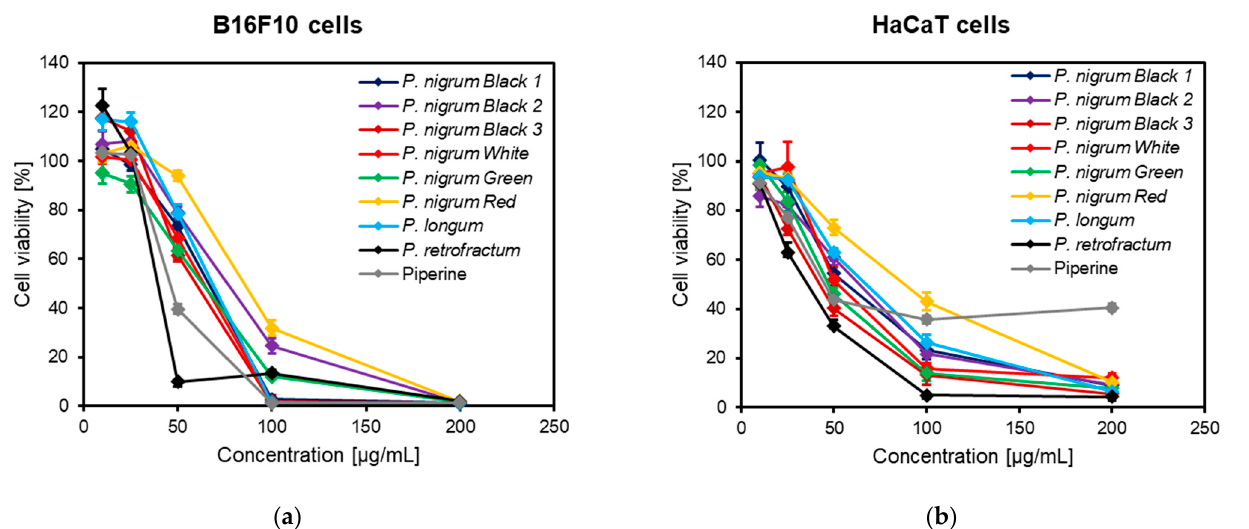
Figure 3. Concentration–response curves (10–200 μ g/mL) showing the effect of the methanolic fruit extracts obtained from different spices of genus Piper and piperine in ( a ) B16F10 and ( b ) HaCaT cells. Cells were seeded in 96-well plates (3 × 10 3 /well) and incubated for 72 h (B16F10 cells) or 48 h (HaCaT cells) with different concentrations of Piper extracts (10–200 μ g/mL) or piperine (10–200 μ g/mL). Data are presented as percentage cell viability (%) in comparison to the solvent (DMSO)-treated control cells, set at 100%.